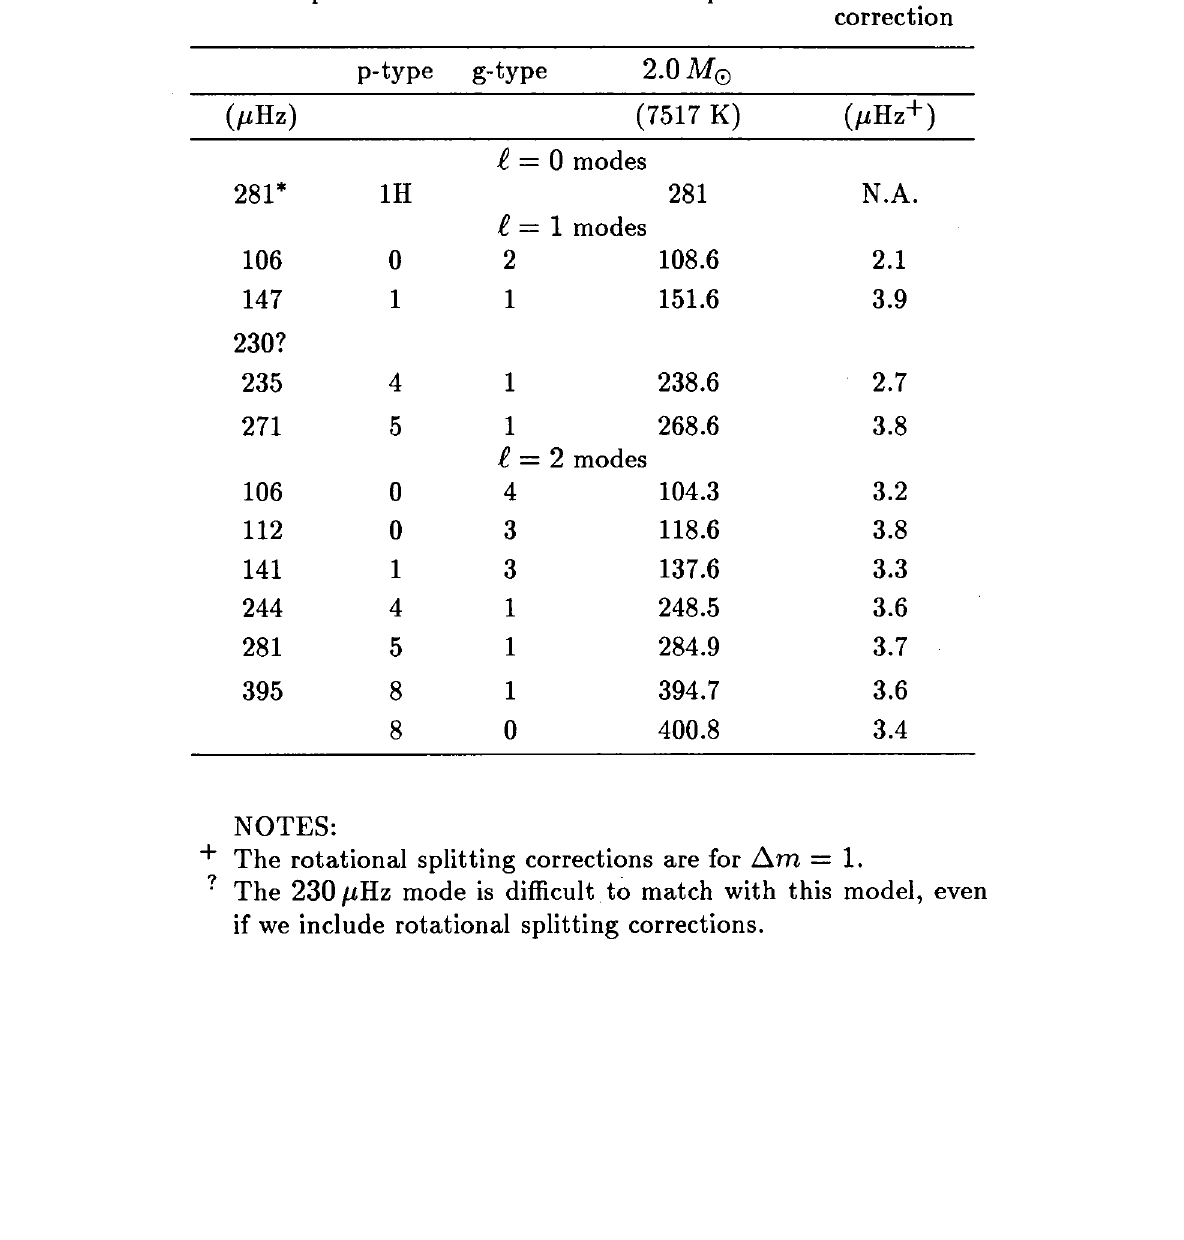
Obs. freq. Ν. of nodes Model